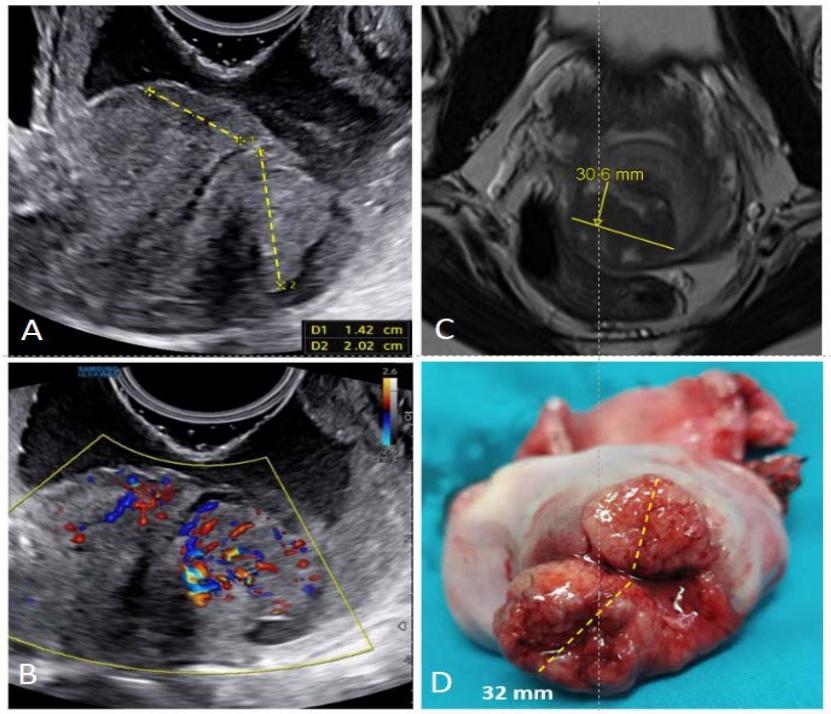
Figure 3. Dimensions with both techniques compared with final histology. VGS image of IB2 N+ squamous tumor ( A , B ), MRI ( C ), and macroscopic appearance ( D ).